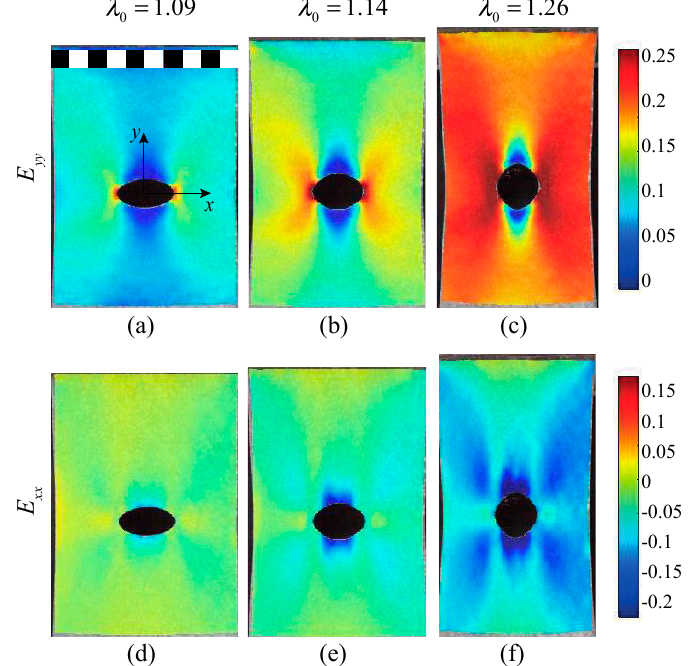
Figure 4. Strain maps obtained from the Digital Image Correlation (DIC) analyses on the elliptically notched specimen El1, for three increasing values of the applied remote stretch λ 0 . ( a – c ) Green–Lagrange strain E yy ; ( d – f ) corresponding maps for the strains E xx . In (a), the length scale is expressed in cm.